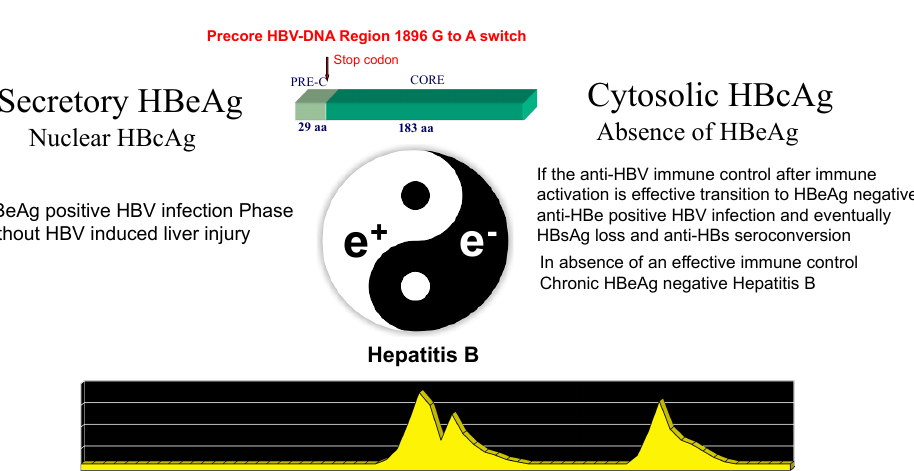
Figure 2. The dynamic change of the protein expression coded by the precore/core HBV-DNA region from the secretory HBeAg to the cytosolic HBcAg pattern conditions the interplay between HBV replication and the host’s immune response. The G1896A mutation inducing a stop codon that blocks the production of the precore leader sequence necessary for HBeAg secretion provides a major functional switch modulating the dynamics of HBeAg expression associated with HBV-induced liver inflammation during chronic HBV